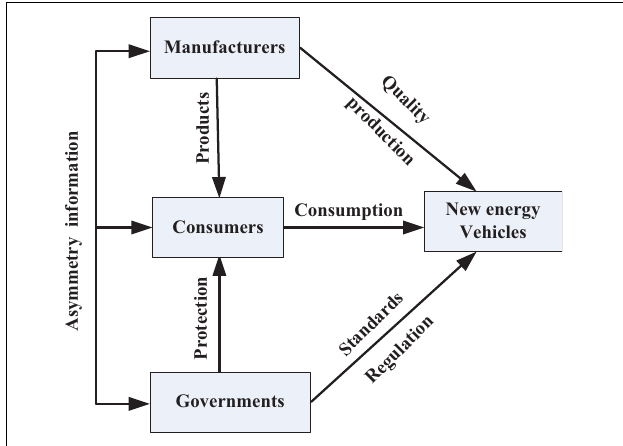
FIGURE 1 | Relationship among stakeholders in NEVs.